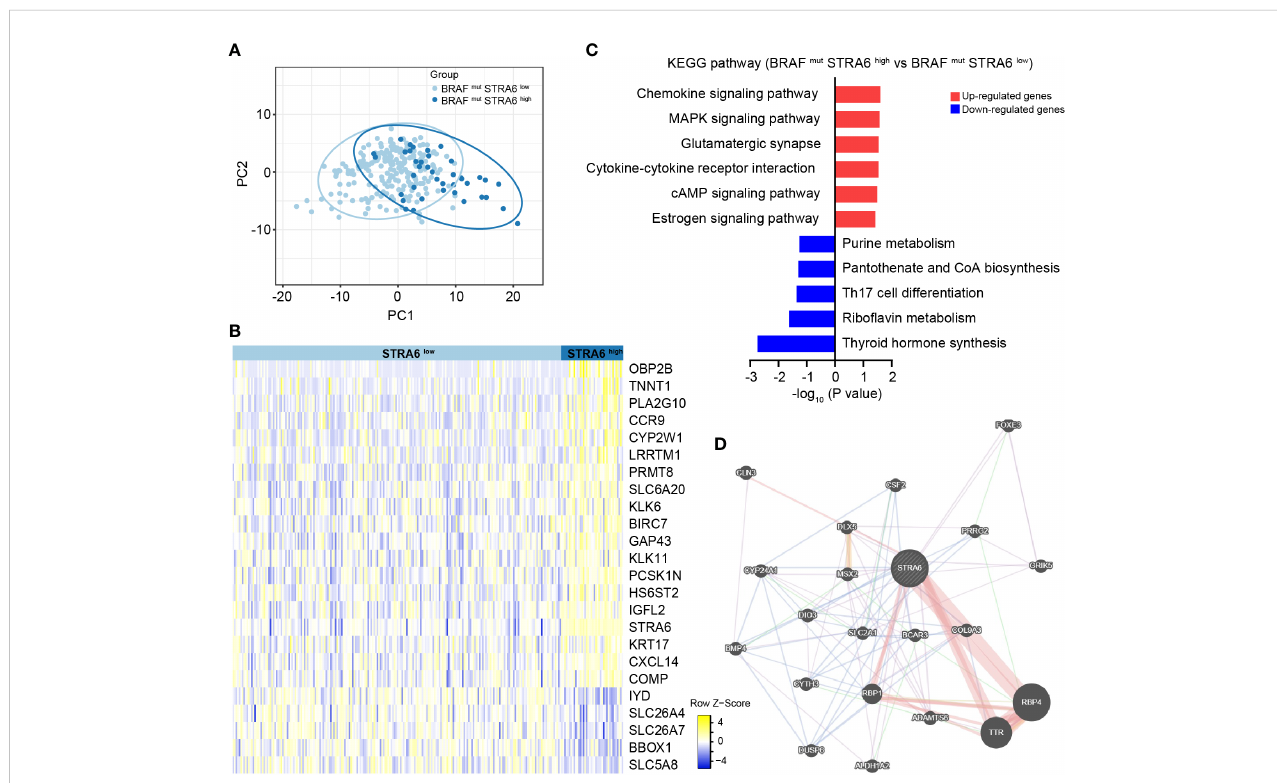
FIGURE 3 STRA6 plays immunoregulatory and oncogenic roles in BRAF-mutated PTC. (A) Principal component analysis (PCA) plot of BRAF-mutated samples based on STRA6 expression. (B) Differently expressed genes (DEGs) between high-STRA6 group and low-STRA6 group. (C) Kyoto Encyclopedia of Genes and Genomes (KEGG) pathway enrichment analysis based on upregulated genes and downregulated genes. (D) Proteins interacted with STRA6 were predicted by